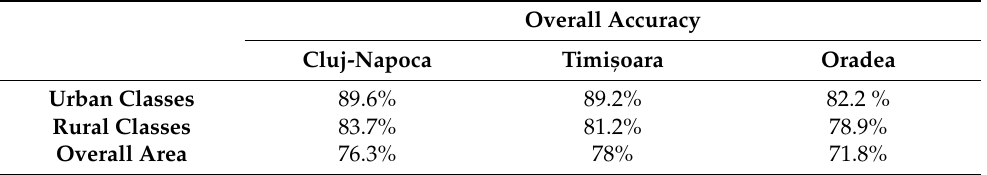
Table 7. Thematic accuracy assessment for 2018 UA data (Source: UA 2018 LU/LC product delivery